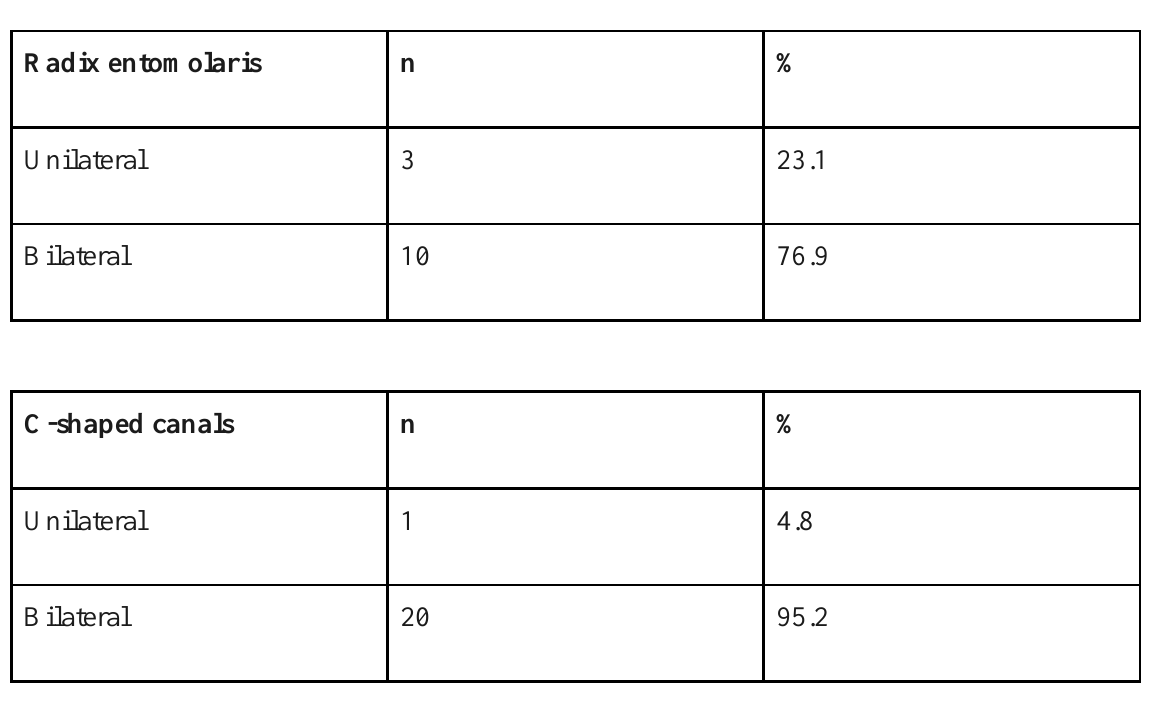
Prevalence of radix entomolaris in mandibular first molars (n=13) and C - shaped canals in mandibular second molars (n=21) examined in terms of lateralisa�on.